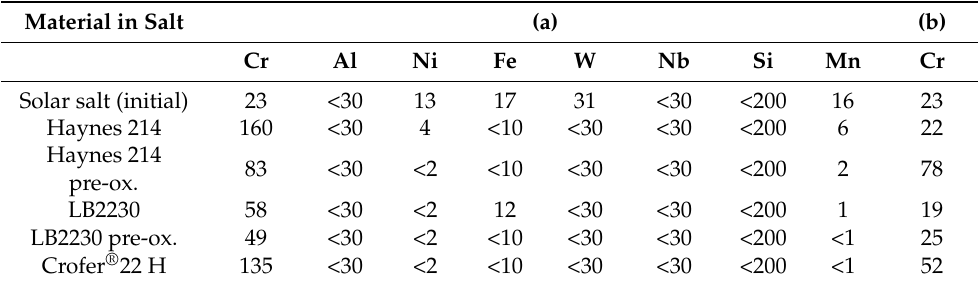
Table 6. Metal species dissolving in solar salt (ppm) over a duration of (a) 0 to 550 h and (b) 1542 to 2042 h (fresh salt applied at 1542 h) of corrosion testing at 600 ◦